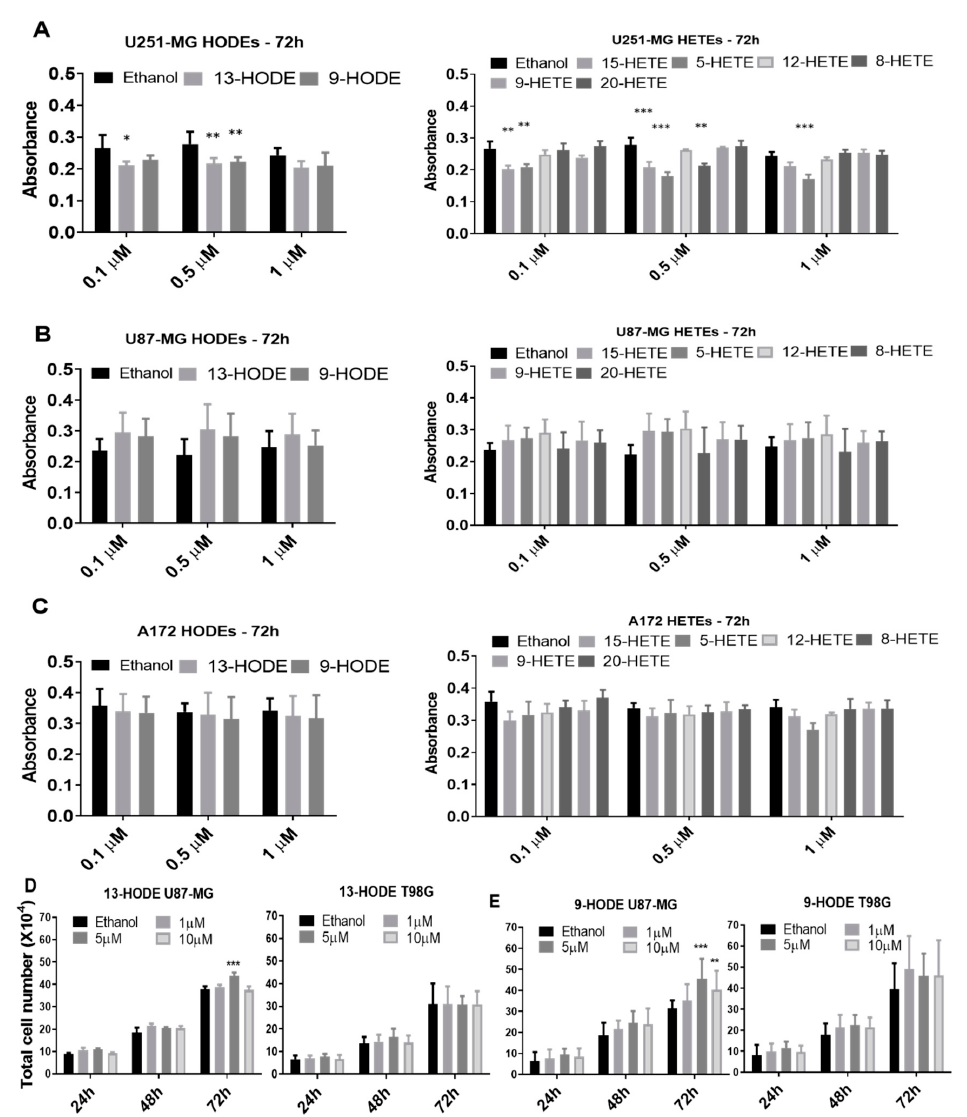
Figure 3. Cell viability of cells treated exogenously with lipids as measured by 3-(4,5-dimethylthiazol- 2-yl)-2,5-diphenyltetrazolium bromide (MTT) conversion ( A – C ). Histograms show MTT